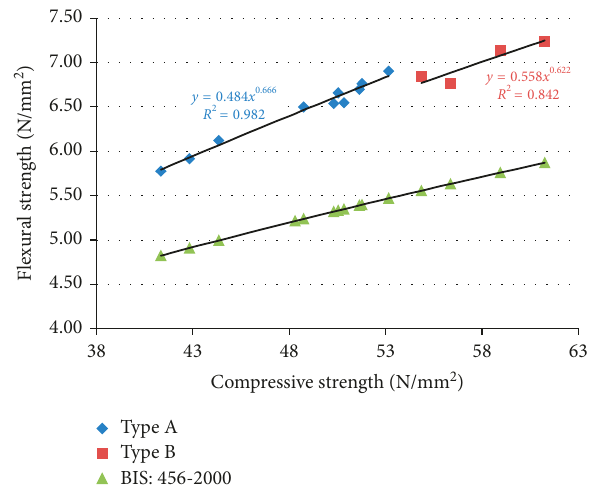
Figure 9: Relationship between flexural strength and compressive strength of concrete mixes at 28 days.